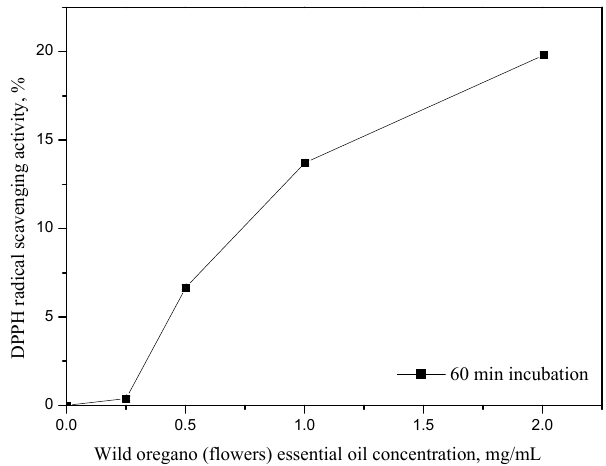
Figure 5. Antioxidant activity of wild oregano (flowers) essential oil. EOs samples from shaded thyme, marjoram, and oregano plants showed higher antioxidant activity than nonshaded plants [17]. In our previous experiment, thyme EOs were reported to be the best antioxidants in comparison to oregano and marjoram [17]. Shade nets provide biosynthesis for components with antioxidant properties [15]. Our results with the covering of oregano plants confirm the findings of Ili ć et al. [24], who reported that lemon balm and mint in full sunlight showed the lowest levels of EOs and a lower antioxidant activity. Shaded basil plants showed higher antioxidant activity than nonshaded basil plants. These results are in agreement with the results of other authors [16,17]. However, in our study, the EC 50 values of the oregano essential oils were slightly different from those identified in other works possibly because of the various oregano plant origins or differences in cultivated oregano (cover plants with nets). Differences in antioxidant activity are evident between cultivated and wild oregano. EC 50 values were higher in wild oregano compared to cultivated oregano, which means that stronger antioxidant activity was recorded in cultivated oregano [55]. Differences in antioxidant activity exist in different parts of plants [56]. Thus, antioxidant activity is similar in flower, leaves and roots, while it is significantly lower in the stem. Origanum species from southwestern Serbia exhibited strong antioxidant activity with EC 50 values between 34.5 and 86 mg/mL [47]. The essential oil of Iranian chemotype ‘‘thymol’’ demonstrated radical scavenging ability with an EC 50 of 2.5 μ g/mL [34]. The comparison of antioxidant activity results published in many papers is difficult to standardize because the data is significantly in-